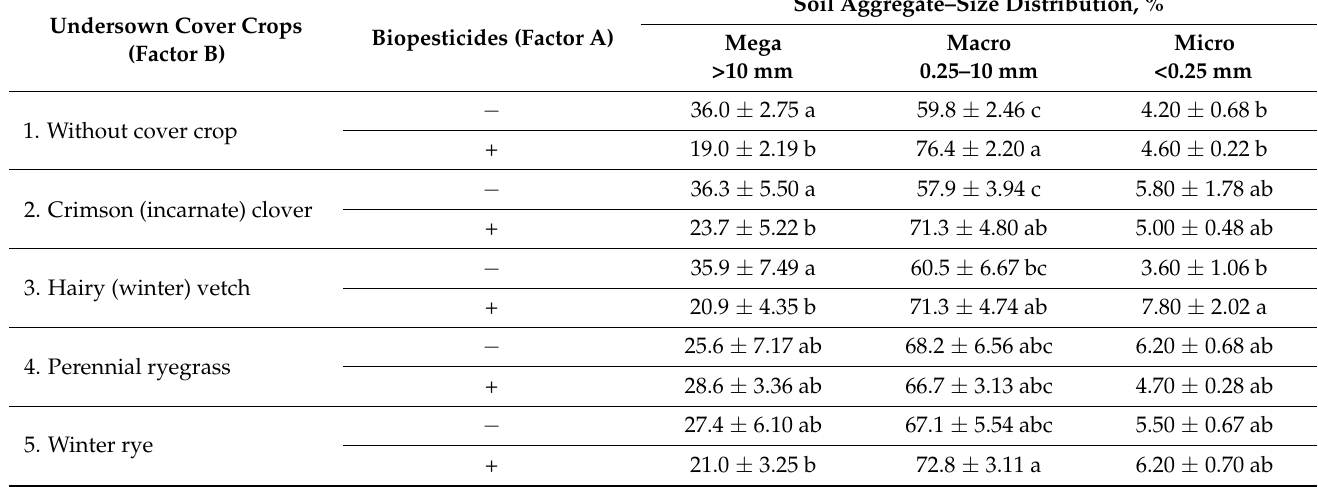
Table 2. Soil aggregate–size distribution,